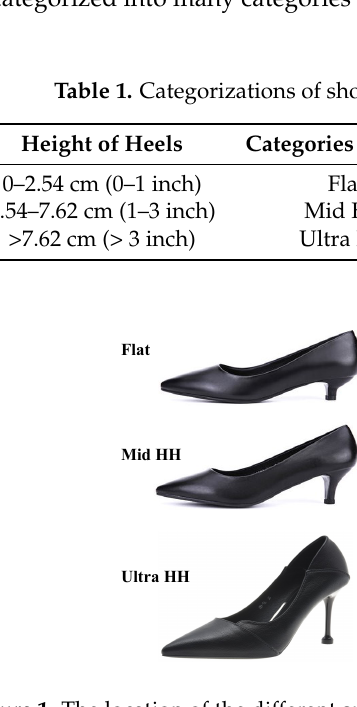
Figure 1. The location of the different